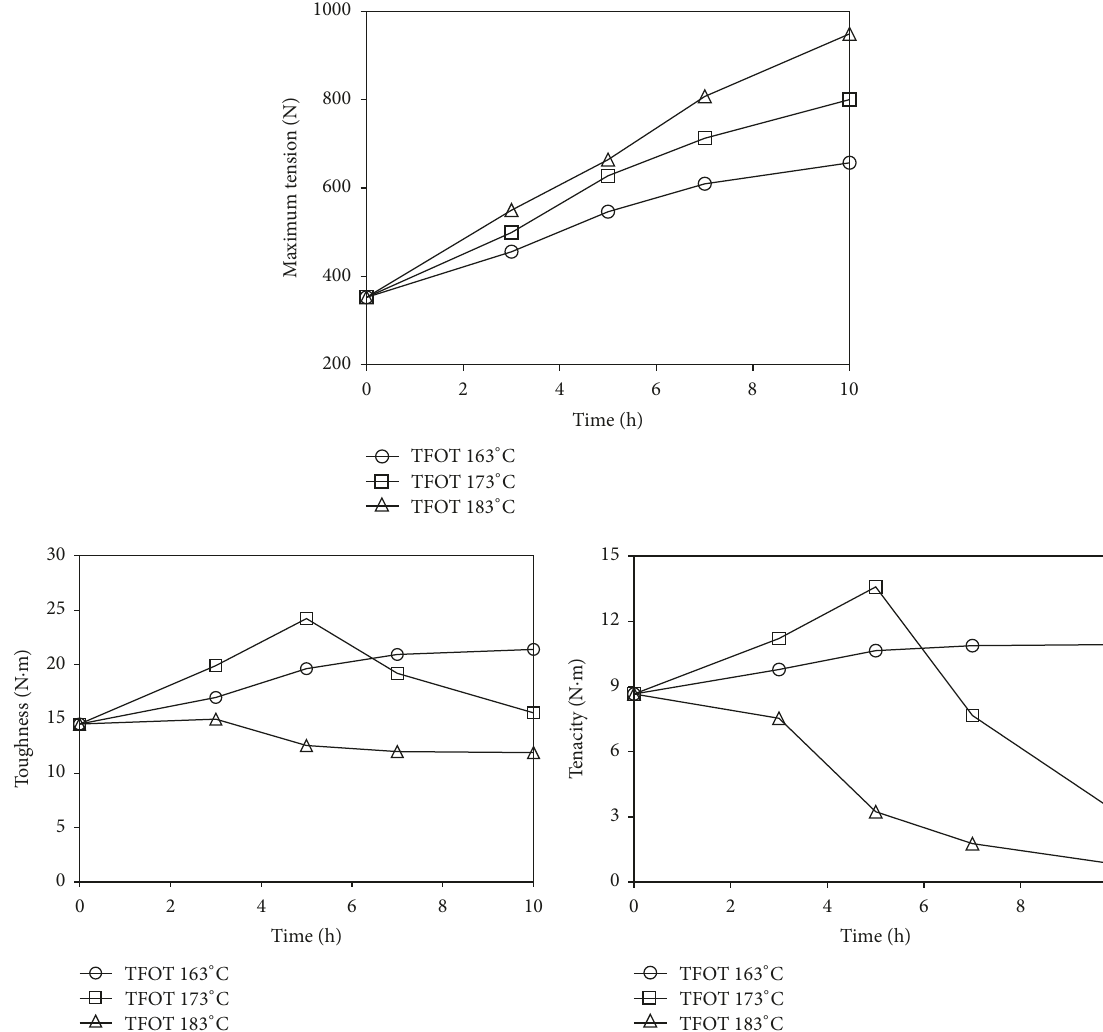
Figure 3: Variation curve of maximum tension, toughness, and tenacity of modified asphalt with the change of aging